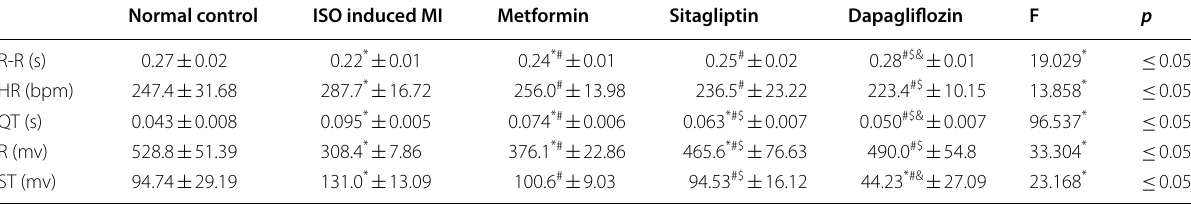
F: F for ANOVA test, Pairwise comparison bet. Each 2 groups was done using Post Hoc Test, (Tukey) *Statistically significant at p 0.05, *: Significant between C-ve and each other group ≤ # Significant between C ve and each other group, $ : Significant between Metformin and each other group + &